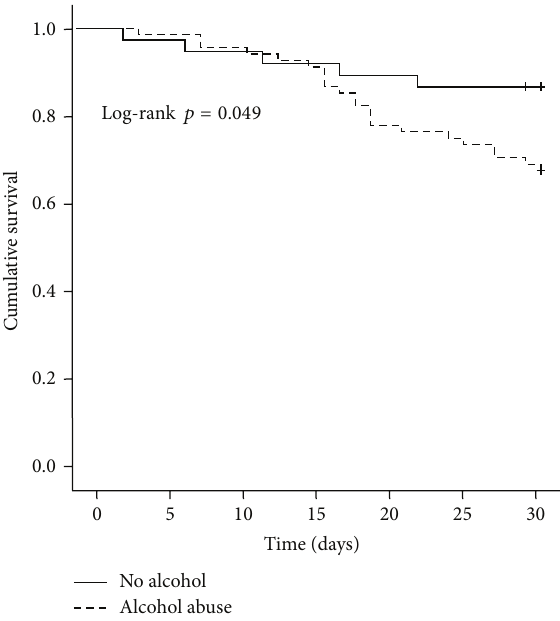
Figure 3: Kaplan-Meier survival analysis of the patient cohort: mean short-term survival was significantly longer in the group without alcohol abuse compared with abusers: 27.9 days [95% CI 26.1–29.8] versus 26.7 days [95% CI 25.2–28.1] (alcohol abuse versus nonalcohol abuse, log-rank test, 𝑝 = 0.049 ).